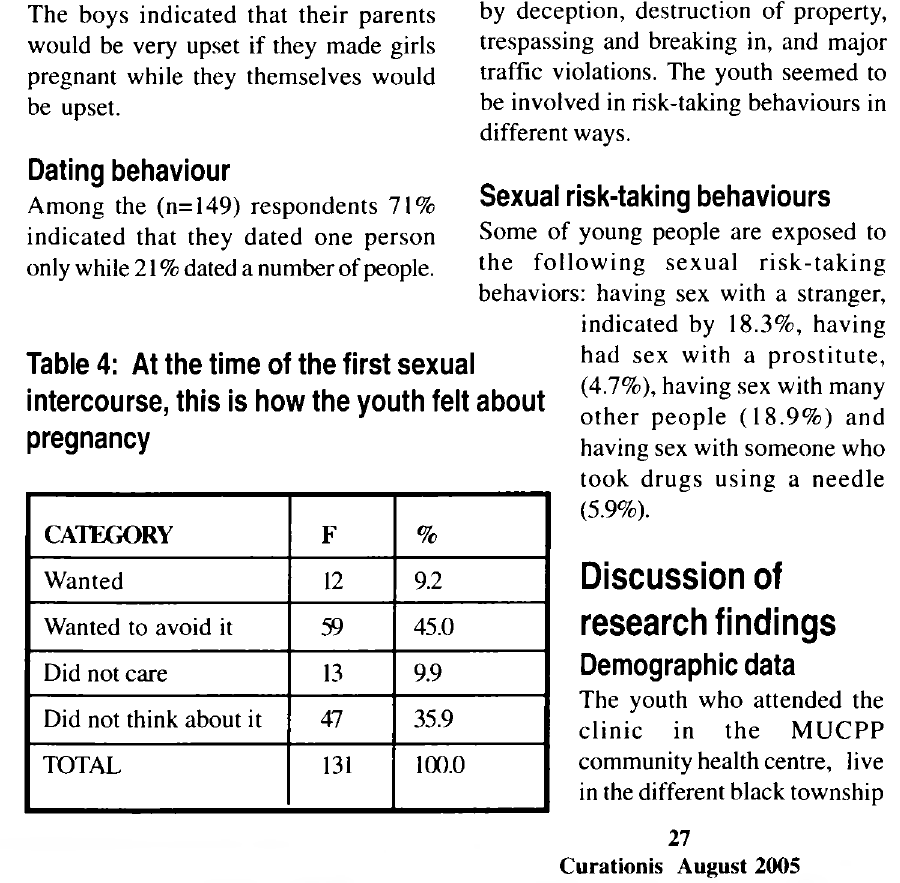
Table 4: At the time of the first